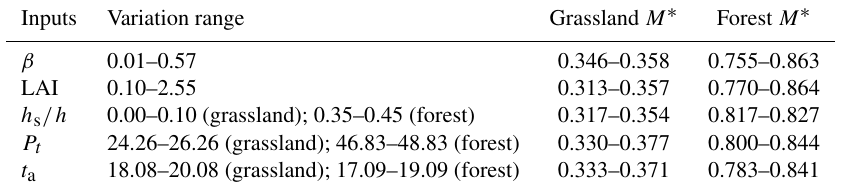
Table 3. The variance of inputs and their corresponding M ∗